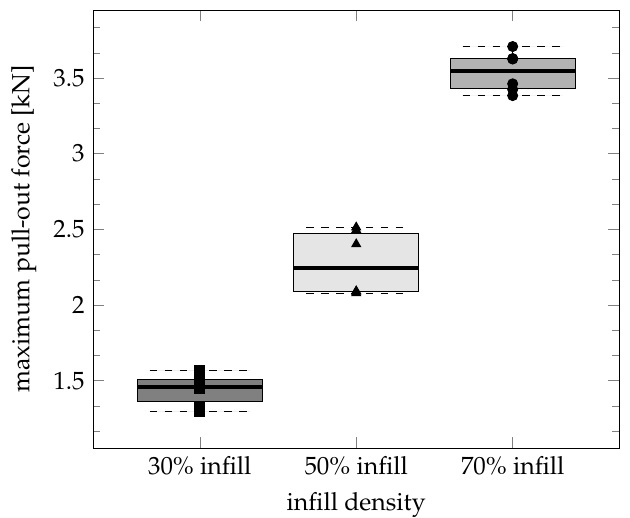
Figure 7. Maximum pull-out forces for variations of the infill density (six specimens